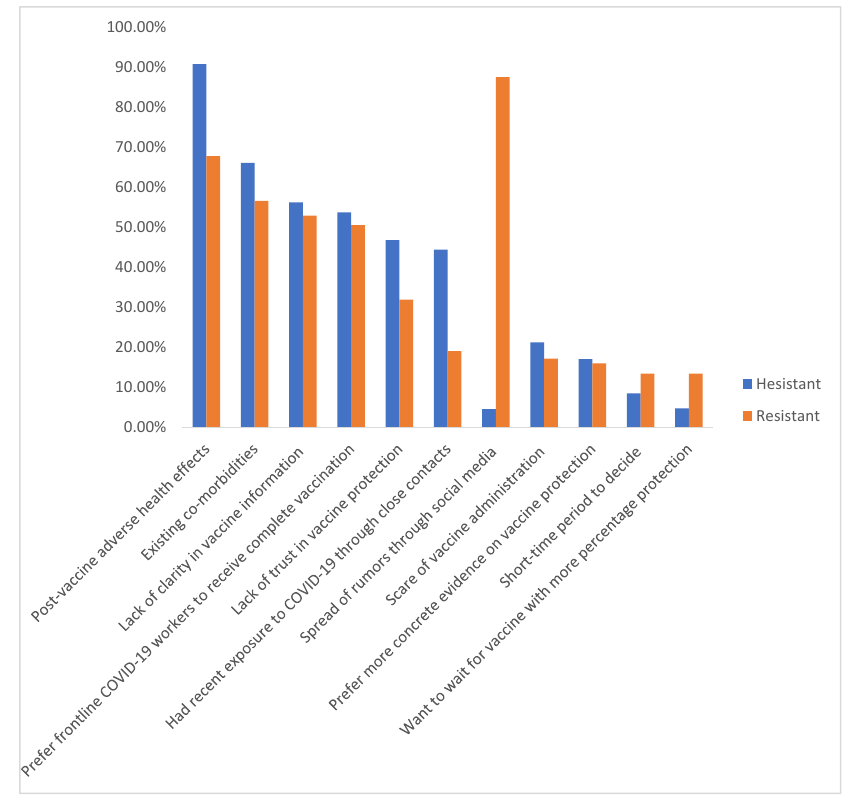
Figure 1. Percentage distribution of reasons for vaccine hesitancy and resistance: the bar chart presented here shows the relevance of post-vaccine adverse health effects (in vaccine-hesitant respondents) and the spread of rumors through close contacts (in vaccine-resistant respondents) being the most common specific reason for their responses. The total number of vaccine-hesitant (N) respondents was 1077, and the total number of vaccine-resistant (N) respondents was 162. However, approximately 61.2% of these re- spondents agreed to consider/change their opinion after a 6-month observation period. This mainly depended on the availability of reasonable information on vaccine safety and vaccine-associated adverse effects. The vaccine-resistant respondents rendered firm disbelief in vaccine efficacy and cited multiple reasons for declining. The vaccine-hesitant respondents were more ready to seek more information about vaccine efficacy and safety from reasonable sources, showed belief in pharmaceutical vaccine research, and were waiting for the government and healthcare facility to upgrade their public service towards COVID-19. Fifty-five per- cent of vaccine-hesitant respondents were interested to be part of survey research studies in the future, but a striking 98% of vaccine-resistant respondents were unconcerned about being part of any future survey studies involving COVID-19 vaccines. Rumors spread through social media occupied 87.6% of vaccine-resistant respondents’ reasons for COVID-19 vaccine denial. The percentage is astonishingly high compared to 4.6% among vaccine-hesitant respondents.